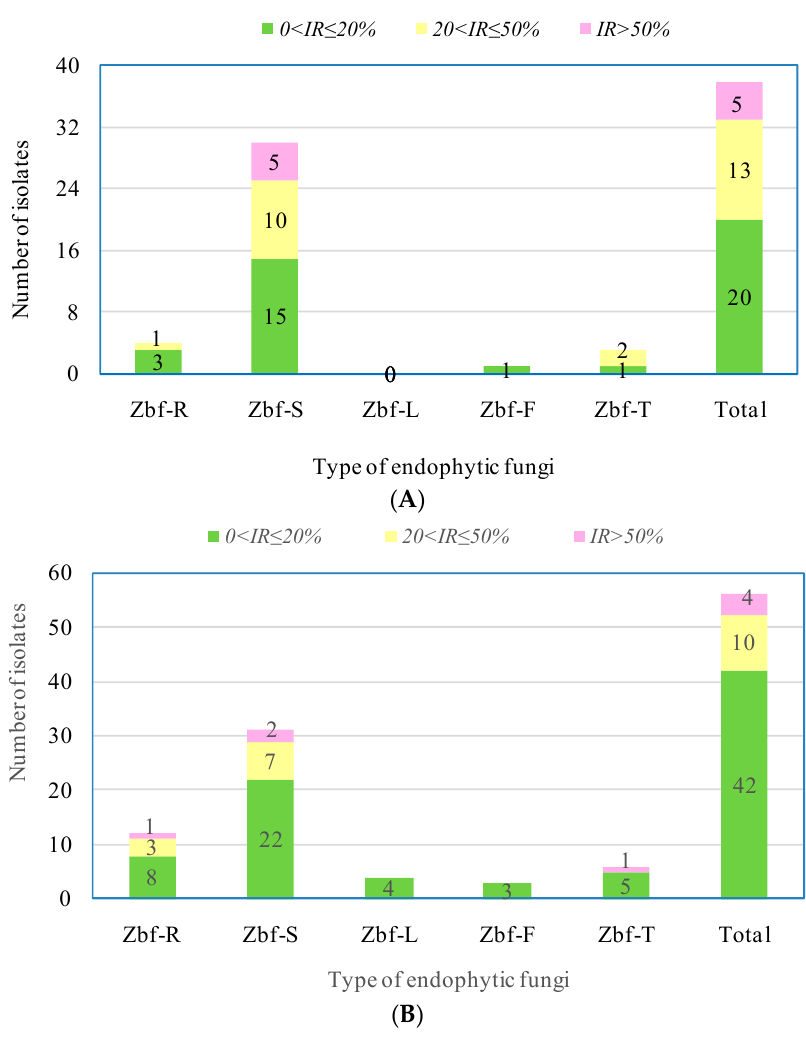
Figure 6. Grading of inhibitory ability of endophytic fungal isolates with inhibition on pathogens F. sambucinum ( A ); and P. zanthoxyli ( B ). The values presented in the graph are the corresponding numbers of endophytic isolates with inhibition respectively locating their corresponding grades.